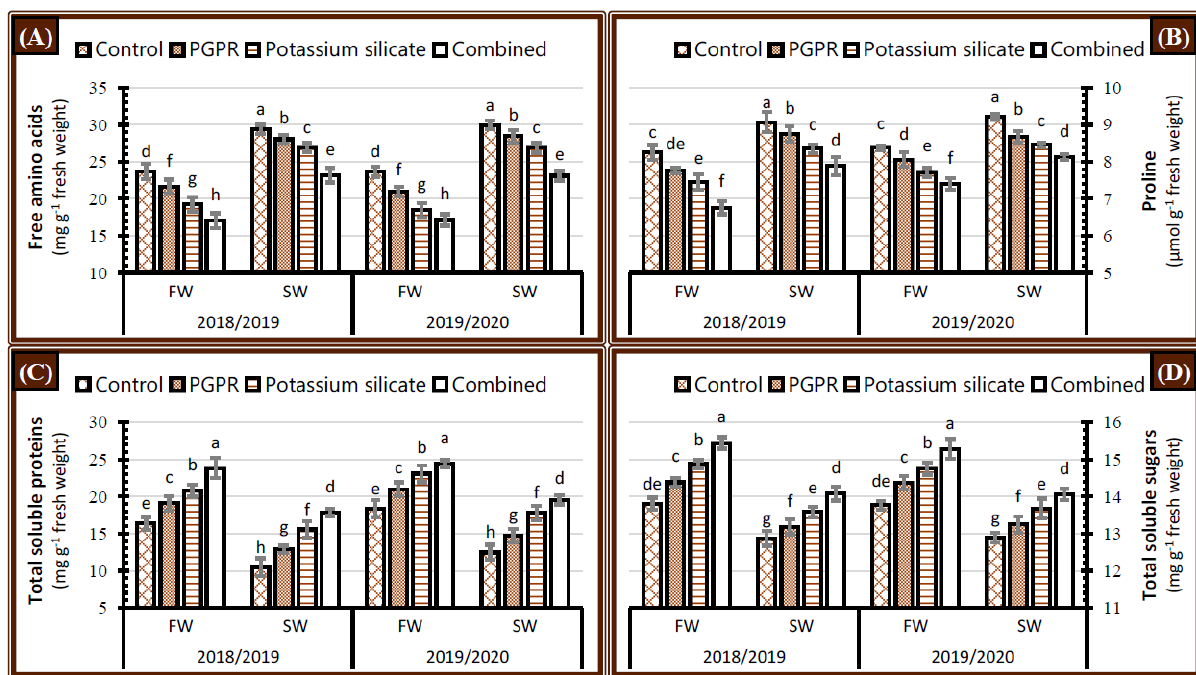
Figure 5. Effect of application of PGPR, potassium silicate and their combination on the concentration of biochemical constituents ( A ) free amino acid, ( B ) proline, ( C ) total soluble proteins, and ( D ) total soluble sugars in the leaves of faba bean plants grown under two irrigation types, i.e., fresh water (FW) and saline water (SW) in salt-affected soil during two growing seasons 2018/2019 and 2019/2020. The data are means ± SD of four replicates. Means values that have the same lower-case letter in each column per season are not significant according to Duncan’s Multiple Range